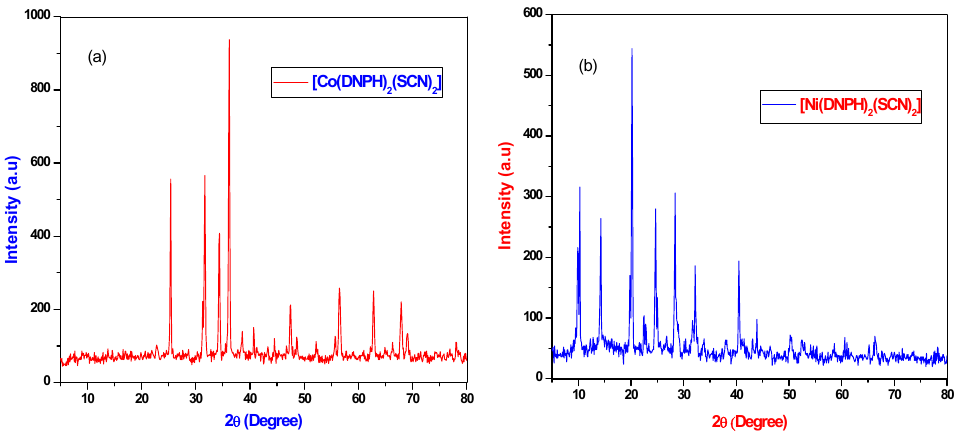
Figure 4. Powder X-ray diffraction (PXRD) patterns of the ( a ) Co(II) complex and ( b ) Ni(II) complex.